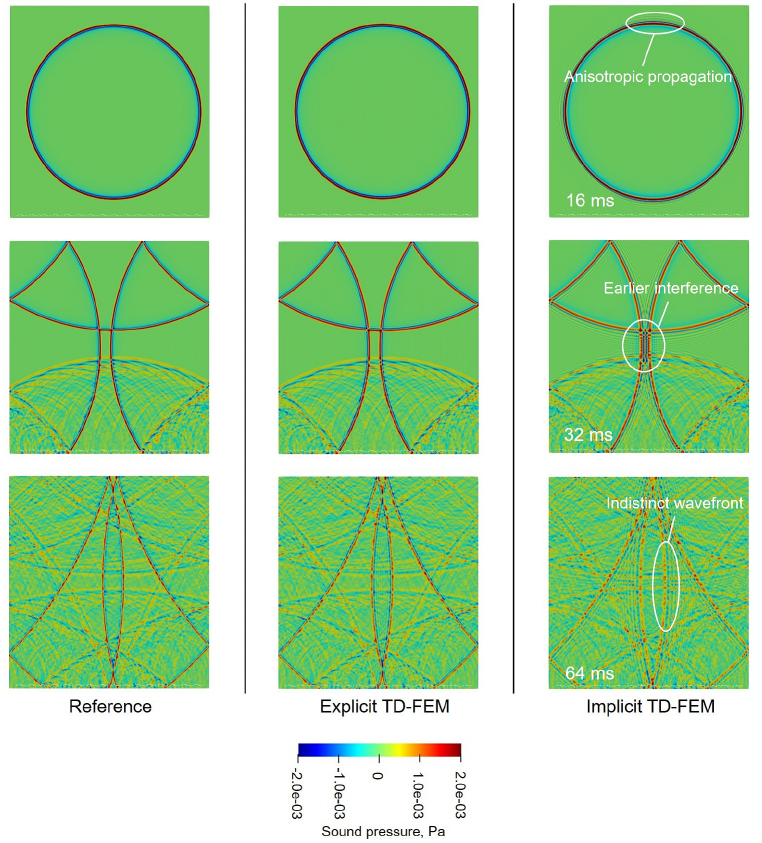
Figure 9. Comparison of sound propagations at t = 16, 32, and 64 ms among ( a ) Reference, ( b ) the proposed explicit TD-FEM and ( c ) the standard implicit